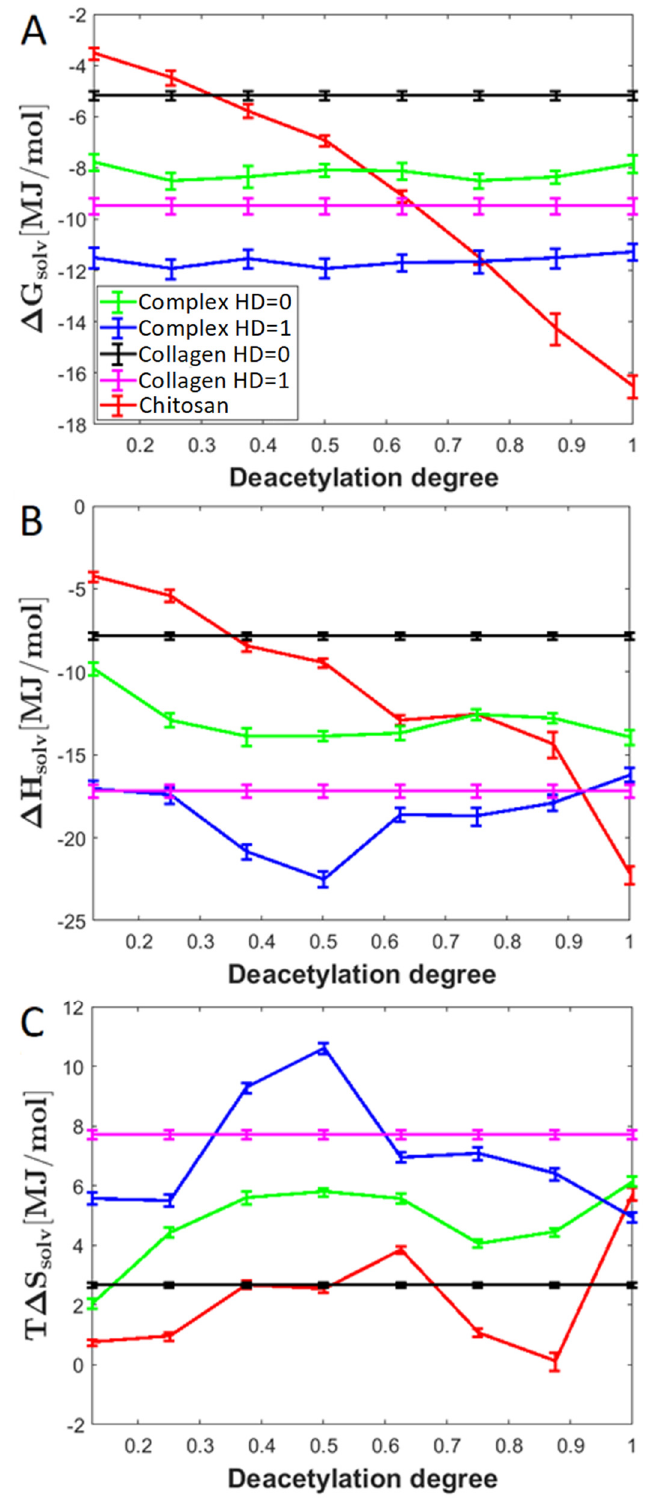
Figure 8. The relationship between solvation Gibbs free energy ( Δ G solv ) and DD ( A ) along with enthalpic ( B ) and entropic ( C ) contributions to solvation for exemplary complexes (HD = 0 and HD = 1) and pure components.